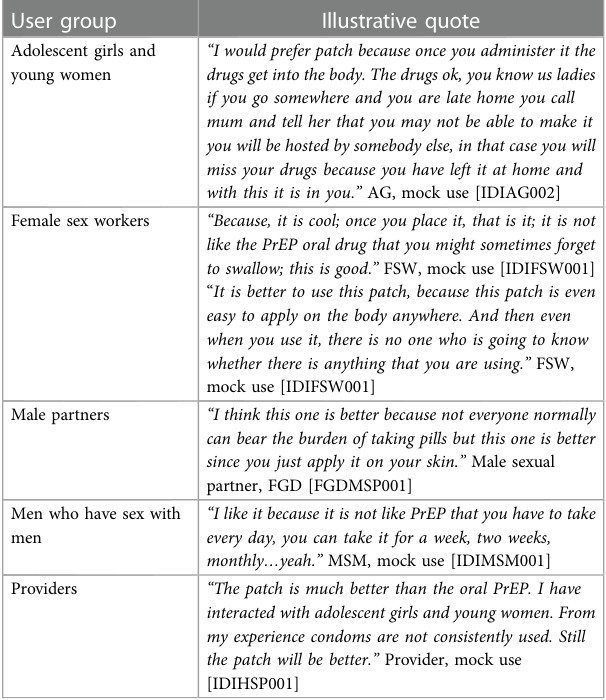
TABLE 4 Illustrative acceptability of the MAP technology, by user group. User group